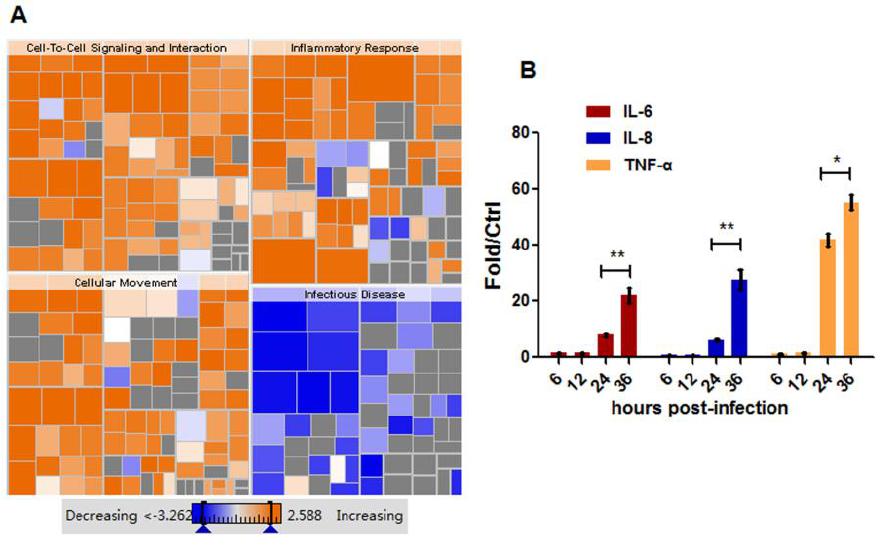
Figure 8. Inflammatory response further strengthened as viral infection